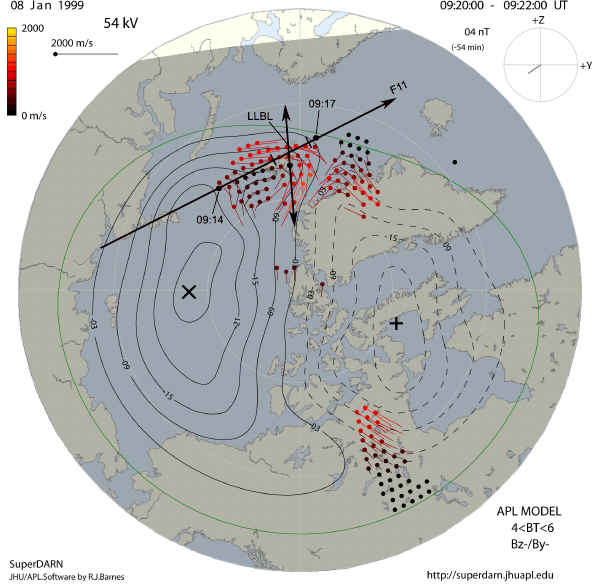
Fig. 19. SuperDARN convection data for 09:20–09:22UT. Same format as in Fig.